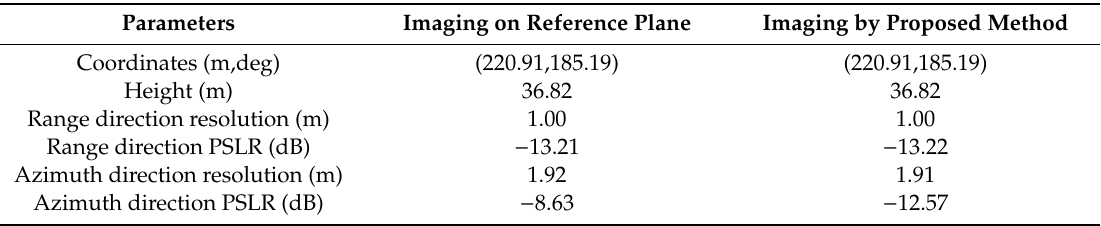
Table 3. The quality parameters of the strong scattering target imaging